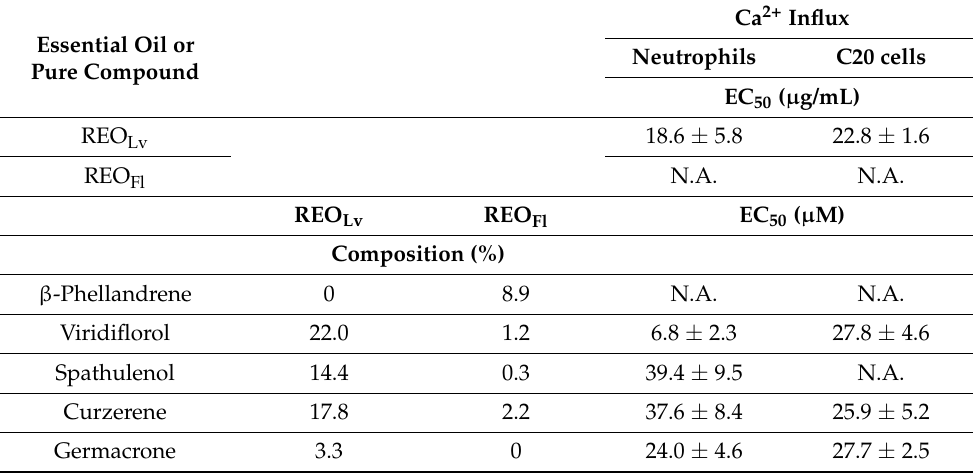
EC 50 values were determined by nonlinear regression analysis of the dose-response curves as described under Materials and Methods . N.A. indicates the samples had essentially no activity (EC 50 >50 µ M or >50 µ g/mL). The data are presented as the mean ± SD of three independent experiments.